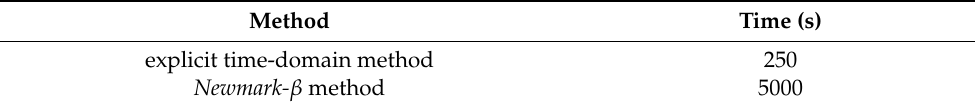
Table 5. Time-consuming comparison of the two methods.